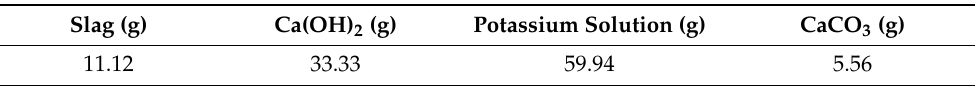
Table 4. Batched masses of R3 mixtures produced for studying the pozzolanic reactivity of the